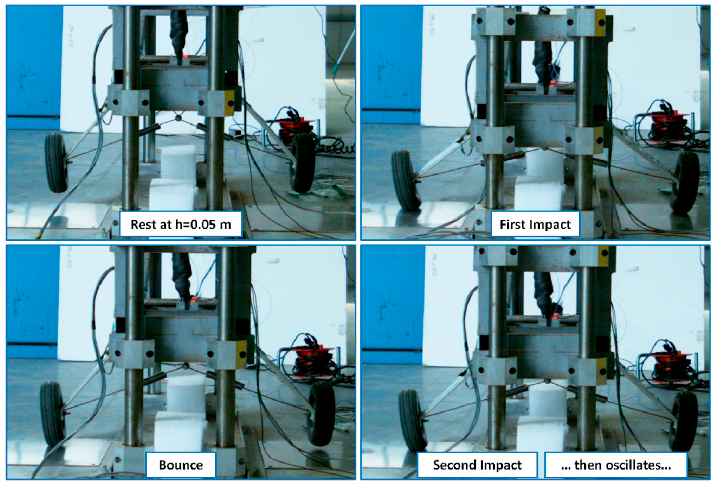
Figure 13. The four main stages of the drop